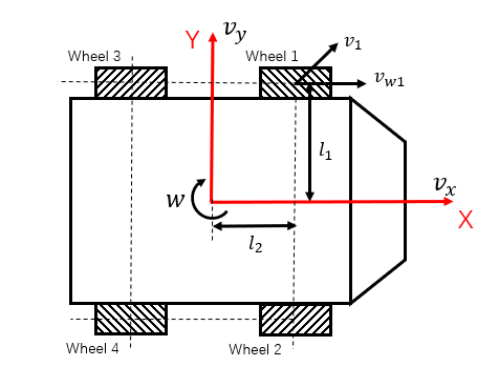
Figure 3. Model of the omnidirectional mobile